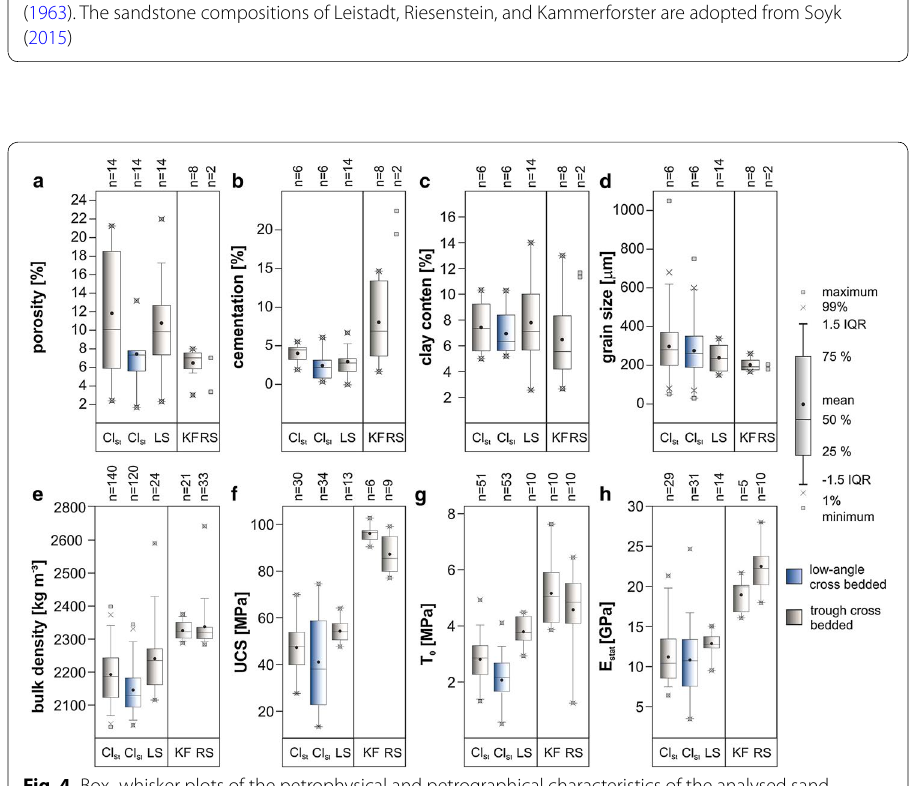
Fig. 4 Box–whisker plots of the petrophysical and petrographical characteristics of the analysed sand‑ stones. Data are presented according to their locations, from west to east. The individual boxes are coloured according to their fabric type. a Porosity, b cementation, c clay content, d grain size, e bulk density, f uniaxial compressive strength ( UCS ) , g indirect tensile strength ( T 0 ) , and h static Young’s modulus E stat . Equivalent information from Leistadt, Riesenstein, and Kammerforster are adopted from Soyk